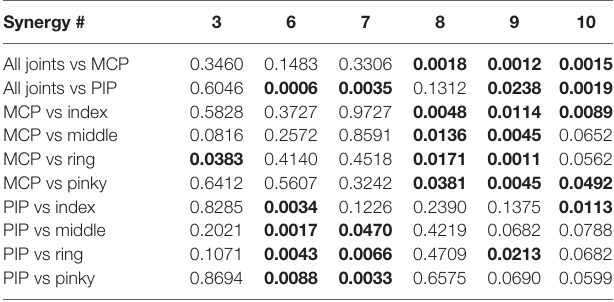
TaBle 1 | significant differences between different synergy configurations.